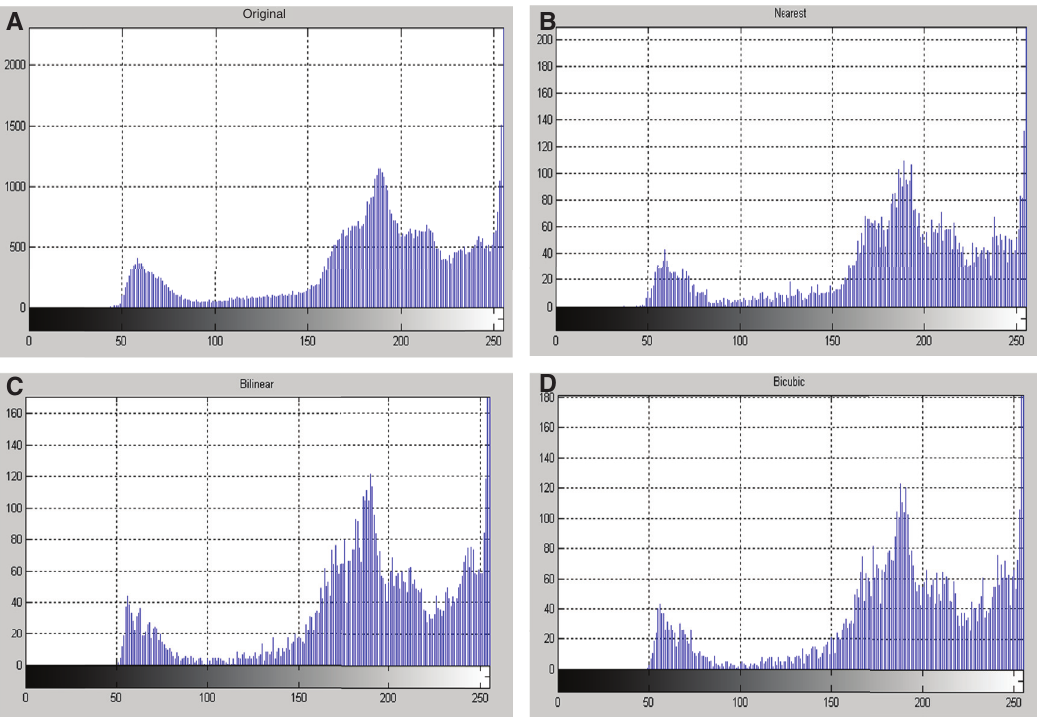
Figure 5. Four Histograms of the Original and Resized Images. (A) Histogram of the original image. (B) Histogram of the resized image using bilinear interpolation method. (C) Histogram of the resized image using the nearest interpolation method. (D) Histogram of the resized image using the cubic interpolation